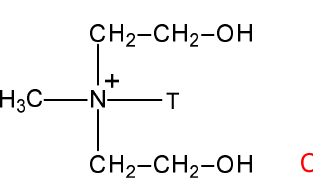
Figure 1. Structure of Cloisite 30B modifier (where T—tallow (~65% C18; ~30% C16; ~5% C14)).